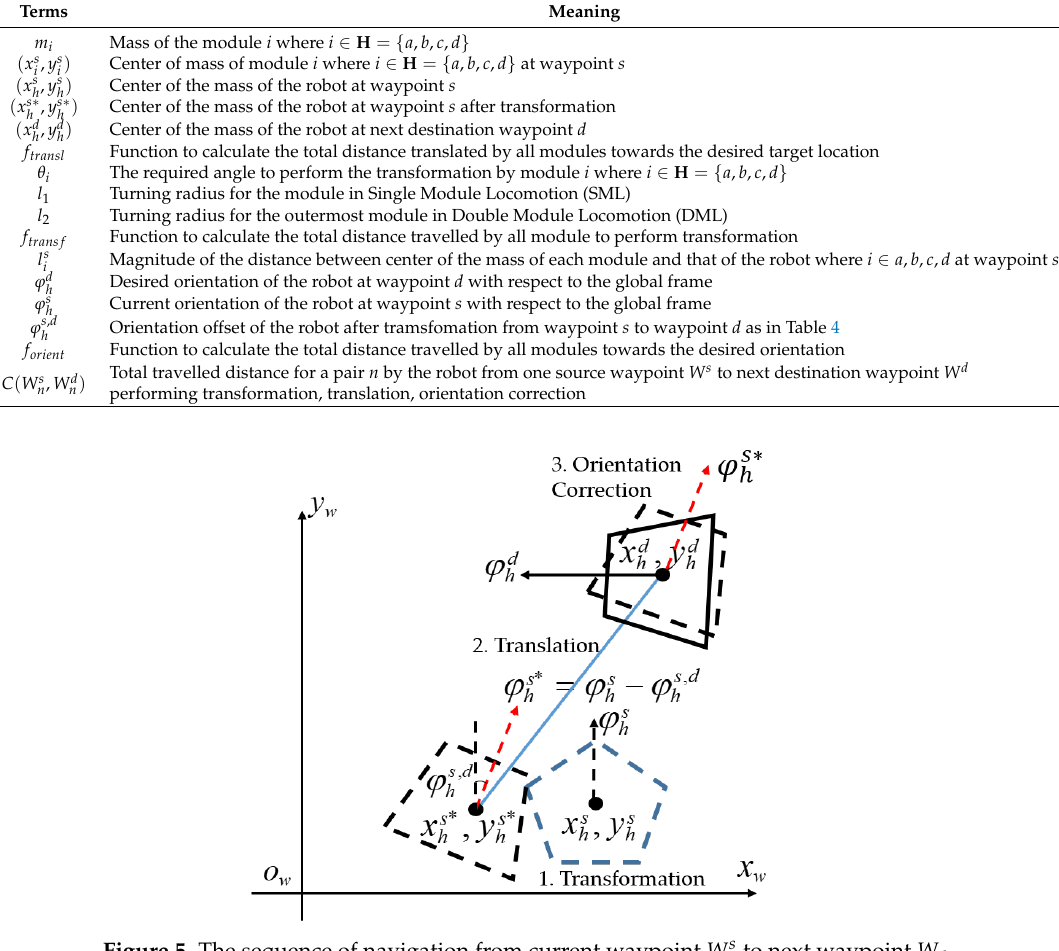
Figure 5. The sequence of navigation from current waypoint W s to next waypoint W d